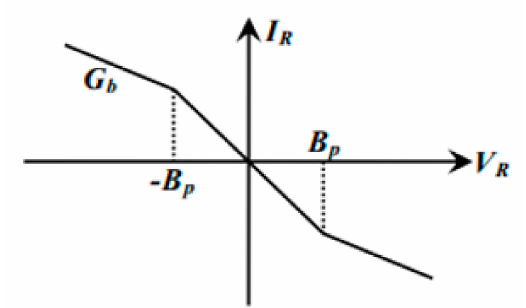
Figure 2. Chua’s circuit voltage-current characteristic